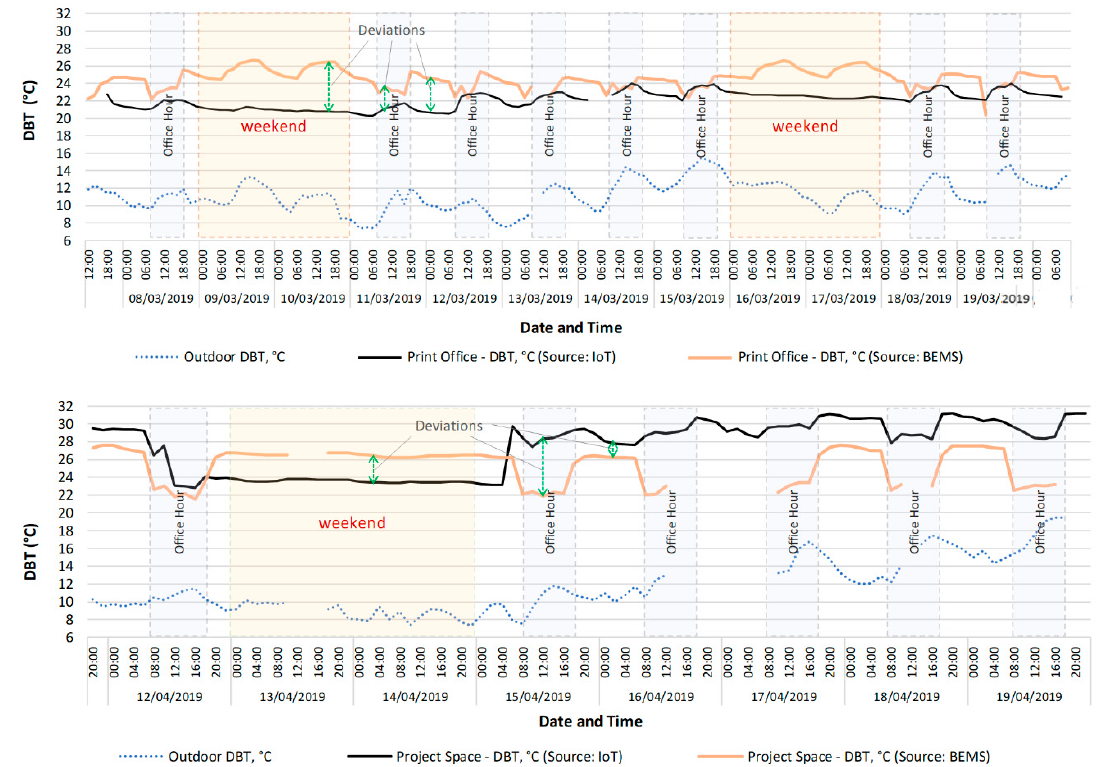
Figure 7. Recorded dry bulb temperatures (DBTs) in Print Office and Project Space (source: IoT and BEMS sensors, outdoor DBT collected from BEMS outdoor space sensor).